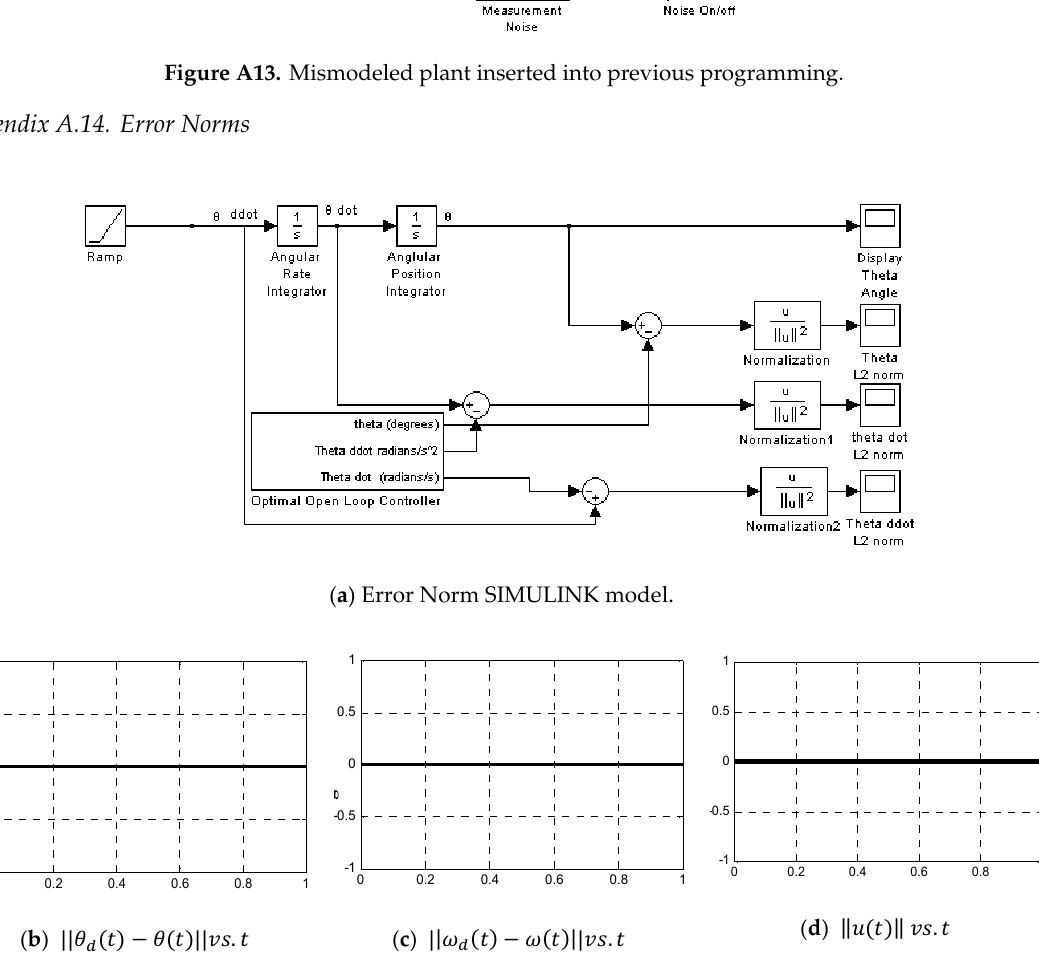
Figure A14. Error norm for optimum controller ( L 2 = 0 when compared to itself).